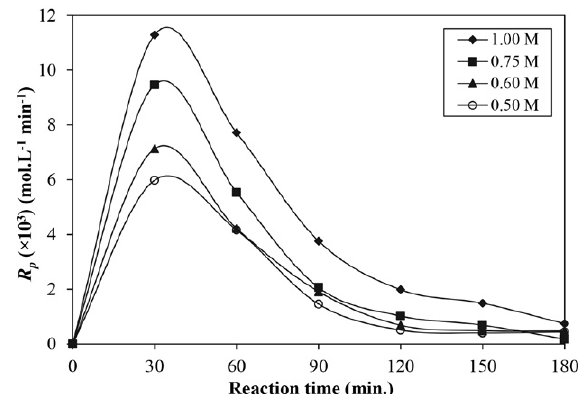
Fig. 4. Rate of polymerization versus reaction time at different ini- tial monomer concentrations (Ultrasound calorimetric power: 11.1 W, APS: wt. % 2, SDS: wt. %